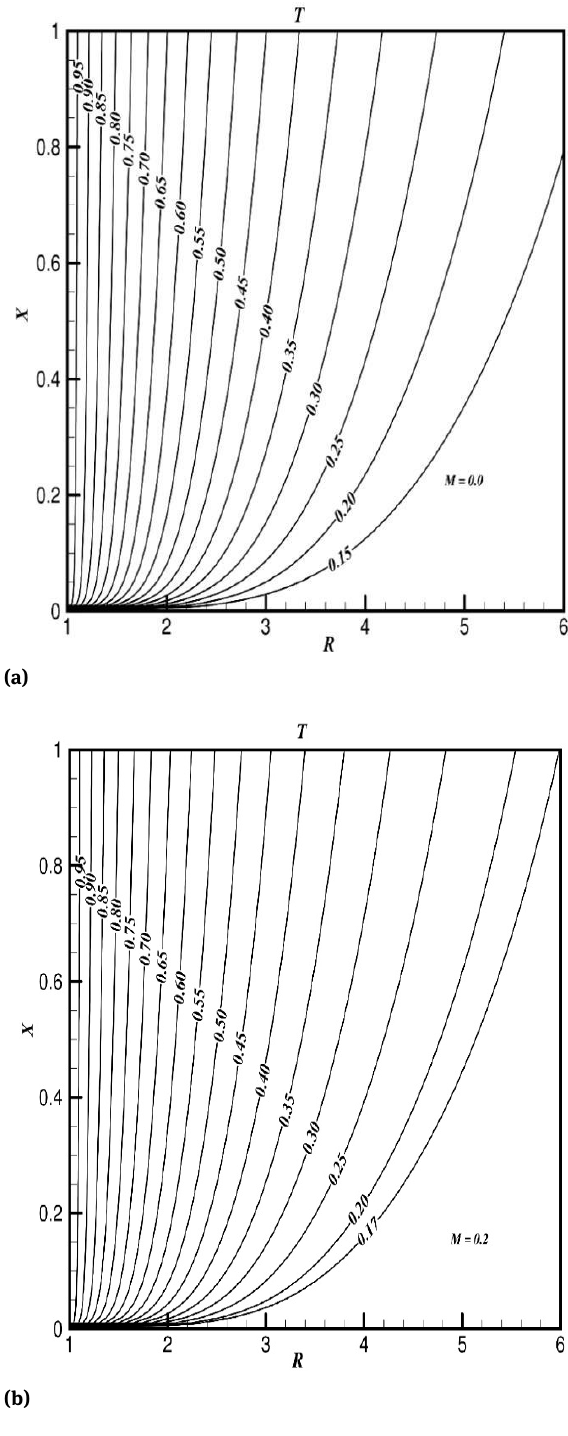
Figure 17: Steady state temperature contours ( a ) M = 0.0 ( b ) M = 0.2 for fixed Sc = 0.6 , Pr = 0.7 , Bu = 1.0 , Kr = −0.2 , Nr = 2.0 , K 1 = 1.0 , Ec = 0.1